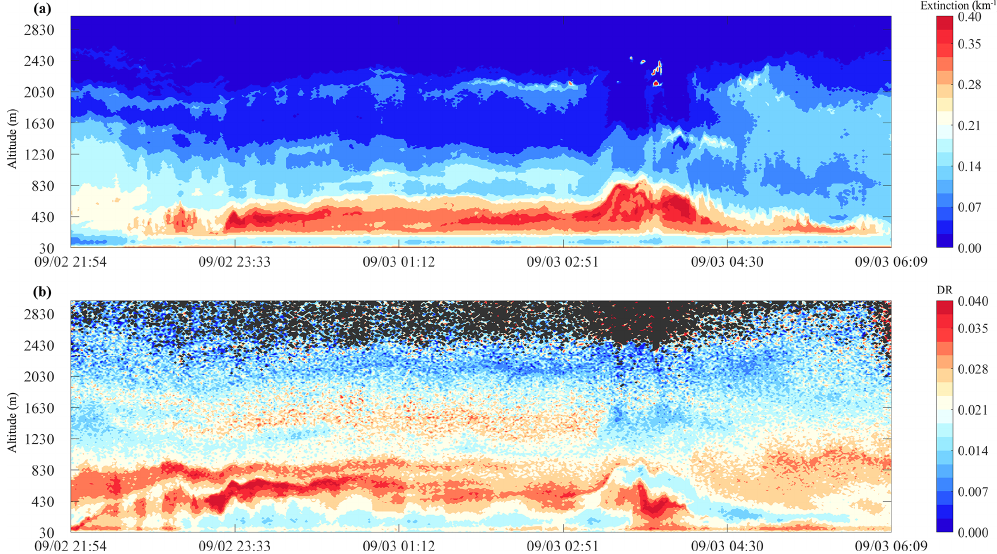
Figure 5. Extinction coefficient (a) and depolarization ratio (b) at 532nm from 21:54LT on 2 September 2020 to 06:09LT on 3 Septem- ber 2020.